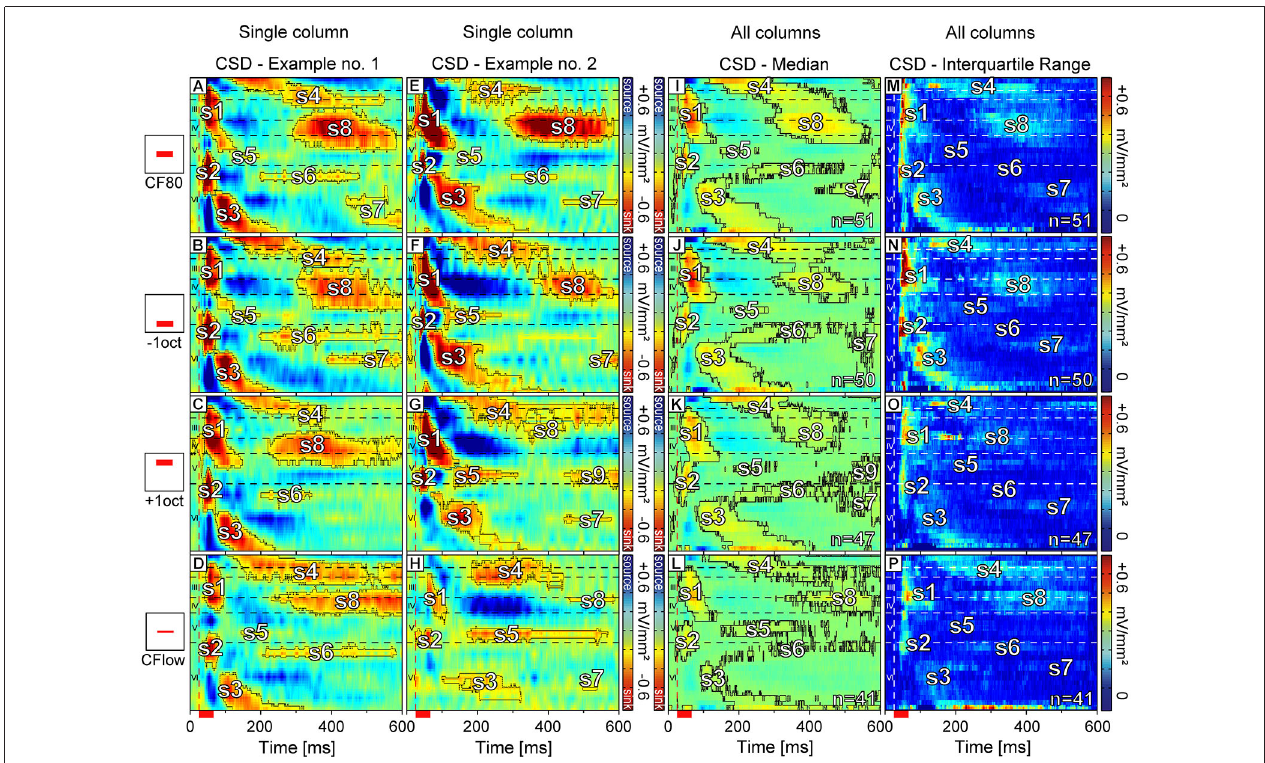
FIGURE 4 | Color maps of representative and averaged laminar CSD profiles. In the first and second column (A–H) representative CSD profiles of the same cortical column are shown. Neurons were stimulated with four different stimuli: sinus at CF at 80 dB SPL (A,E) , sinus at CF one octave below (B,F) , sinus at CF one octave above (C,G) , and sinus at CF with a level set ≤ 24 dB above the individual MT (D,H) . Sink contours were calculated at 8% of the maximum sink strength of the respective CSD pattern elicited by CF80 stimulation. (I–L) The median of laminar profiles averaged over all recording sites for each stimulus respectively. Sink contours were calculated at 4% of the maximum sink strength of the respective CSD pattern elicited by CF80 stimulation. (M–P) The interquartile range of sinks for each stimulus group specifically. Horizontal dashed lines indicate layer borders while the vertical dashed line marks the beginning of pure tone stimulation. Red scale bar represents stimulus duration of 30